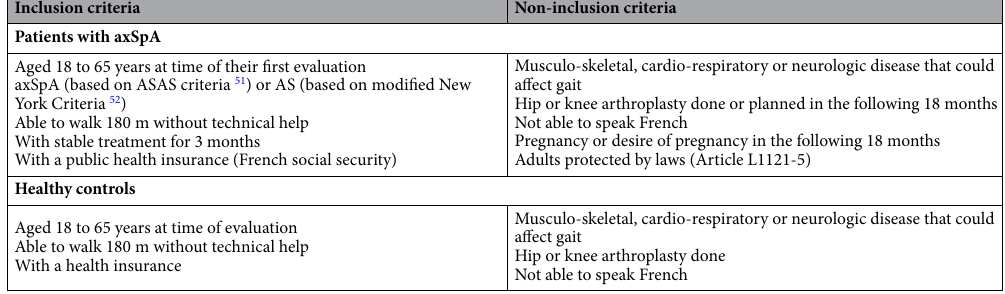
Table 1. Inclusion and non-inclusion criteria for patients with axial spondyloarthritis and healthy controls. axSpA axial spondyloarthritis, AS ankylosing